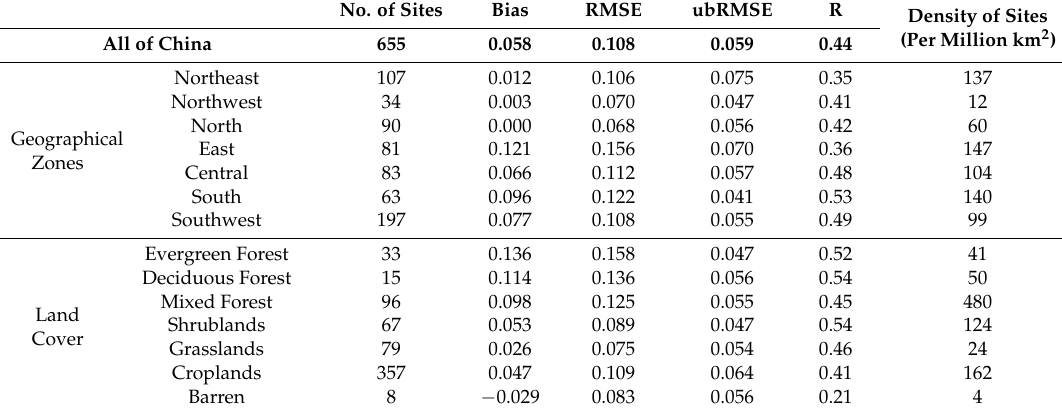
Table 1. The differences between SMAP radiometer soil moisture retrievals and in situ soil moisture observations over continental China based on the original data (1 April 2015—31 August